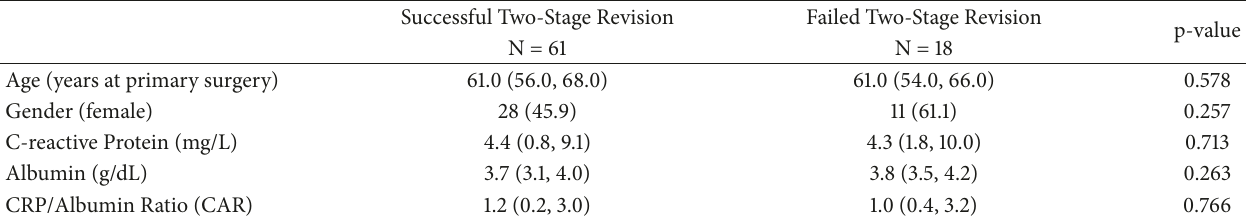
Table 1: Demographic and laboratory data of successful and failed two-stage revision